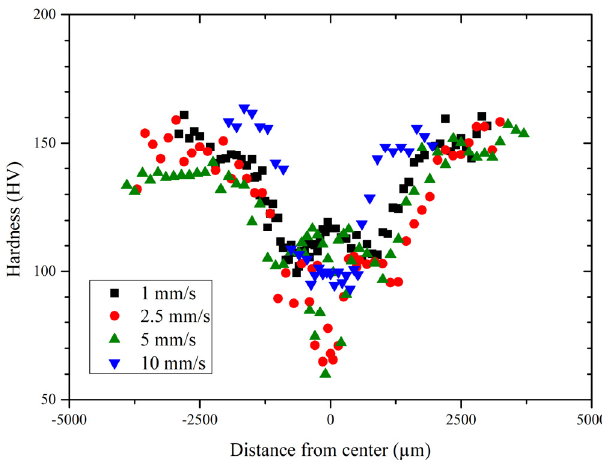
Figure 3. Hardness profiles beneath the 200 W laser irradiated surfaces.